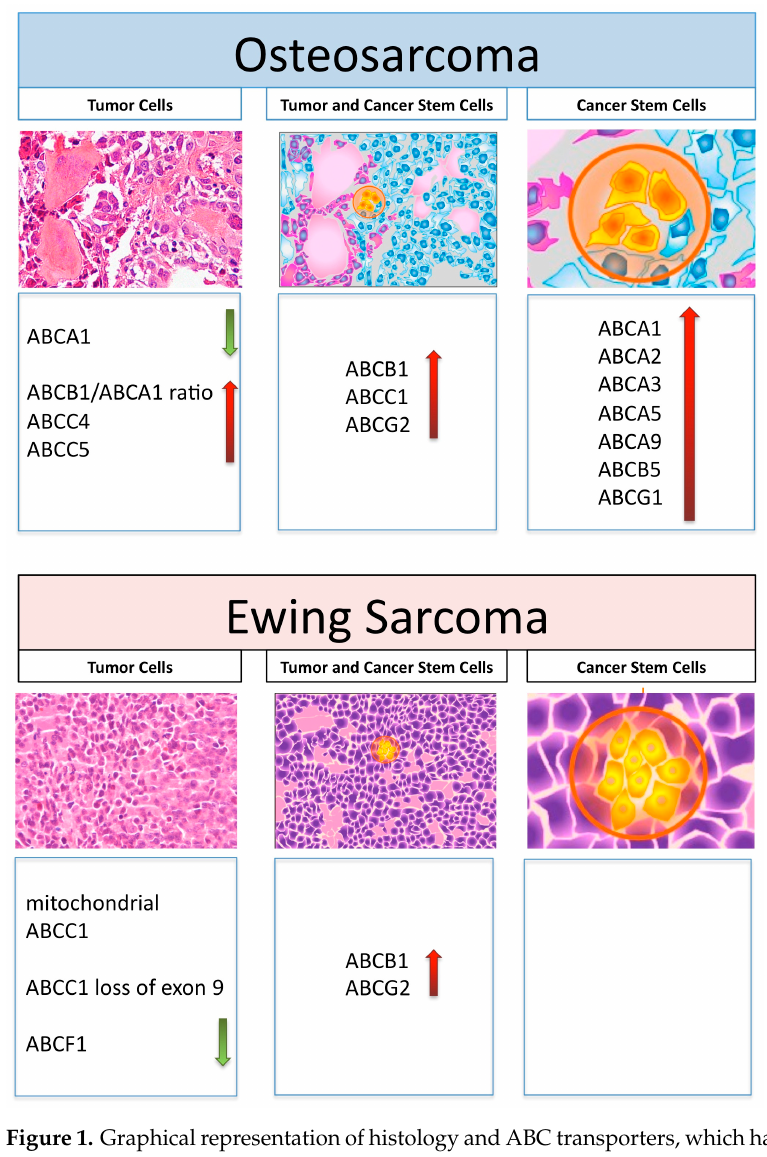
Figure 1. Graphical representation of histology and ABC transporters, which have been reported to be involved in drug resistance in tumor cells or cancer stem cells and in both cell types in osteosarcoma and Ewing’s sarcoma. Increased and decreased expression levels are shown by red and green arrows,